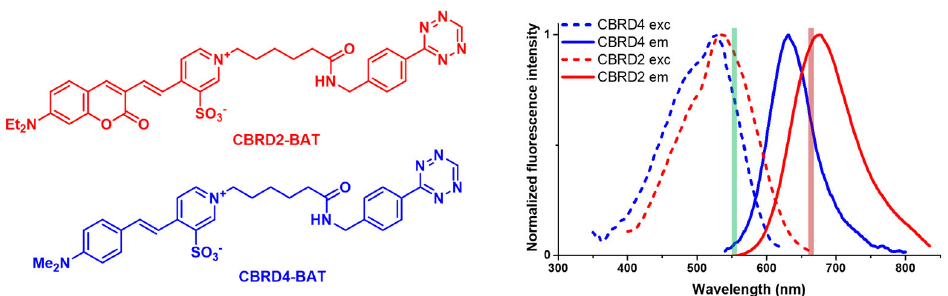
Figure 1. Structures, excitation and fluorescence spectra of dyes CBRD2-BAT and CBRD4-BAT and wavelength of the excitation and depletion lasers (green and red lines, respectively).